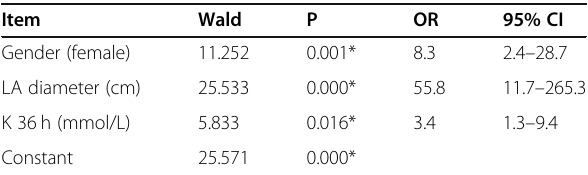
Table 3 Backward, stepwise, multivariable binomial logistic regression analysis for predictors of postoperative atrial